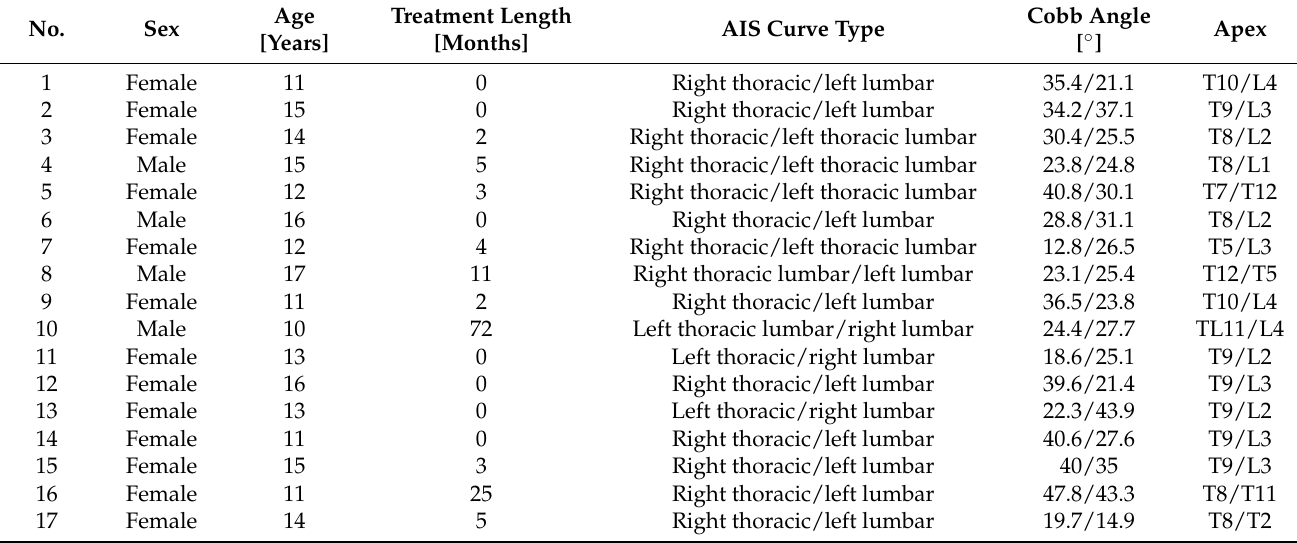
Table 1. Characteristics of the 17